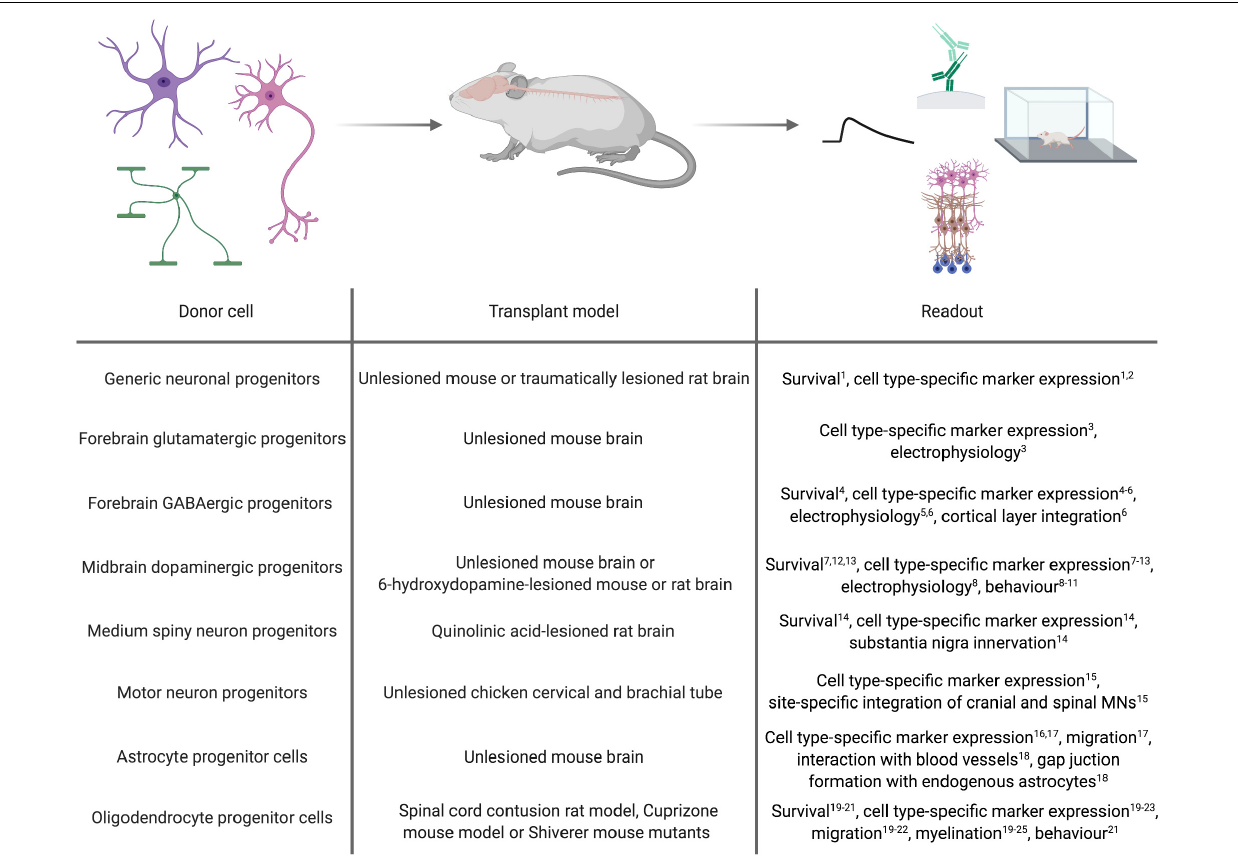
FIGURE 2 | In vivo applications of cell types derived by forward programming. Numbers in superscript relate to references cited in Tables 1 , 2